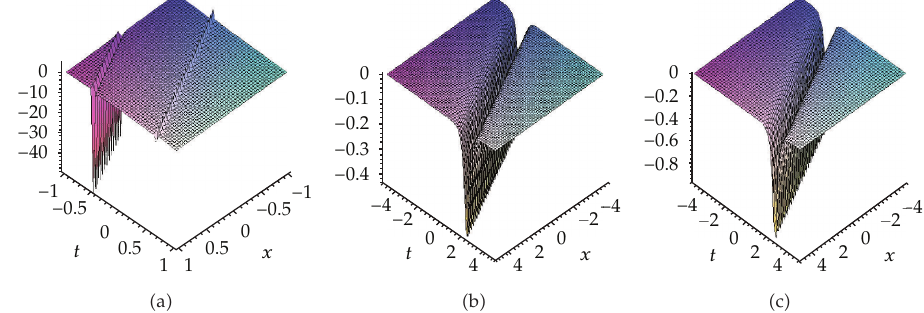
Figure 2: Evolutional behaviour of u 1 describes dark soliton: (cid:3) a (cid:4) p (cid:7) 1 , q (cid:7) 1 / 32 (cid:3) singular wave solution (cid:4) ; (cid:3) b (cid:4) p (cid:7) 1 , q (cid:7) 3; (cid:3) c (cid:4) p (cid:7) 1 , q (cid:7) 27.